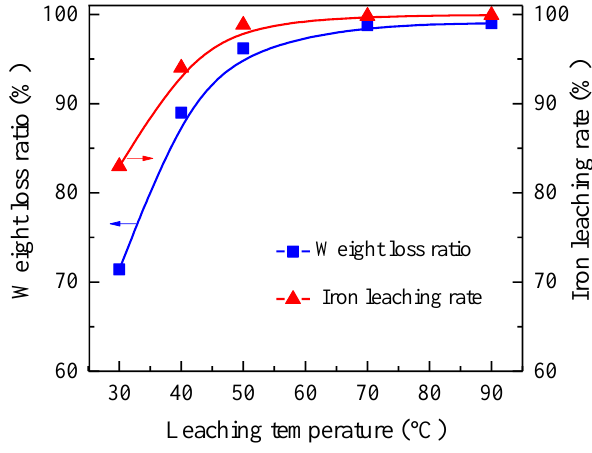
Figure 9. Effect of acid-leaching temperature on iron dissolution of reduced iron powders.